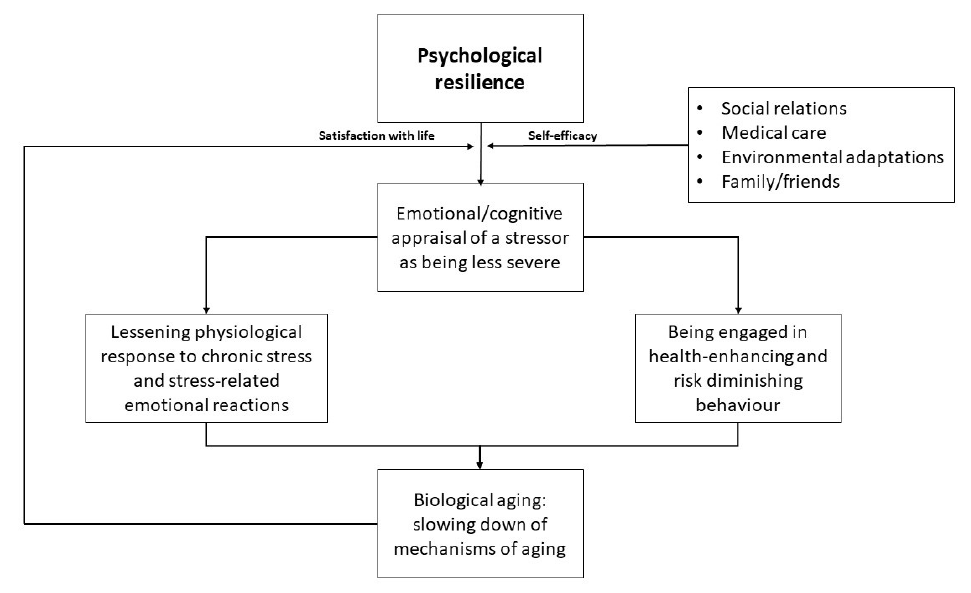
Figure 1. The intersection between psychological and biological resilience in older individuals.